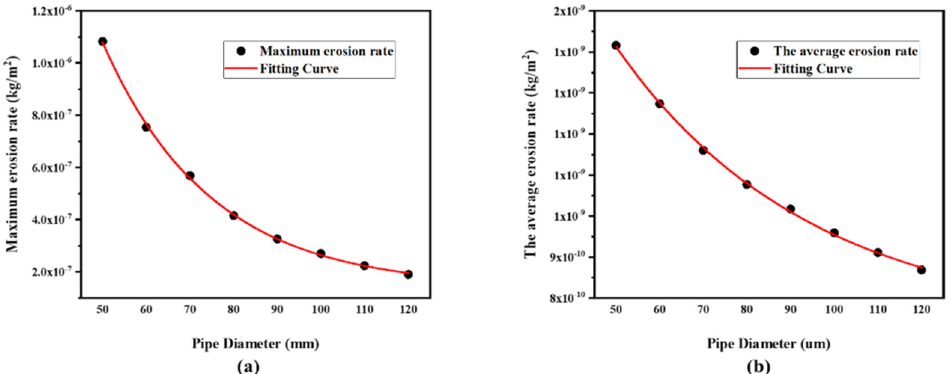
Figure 25. Fitting curves of erosion rates for different pipe diameters: ( a ) Maximum erosion rates for different pipe diameters ( b ) Average erosion rates for different pipe diameters.